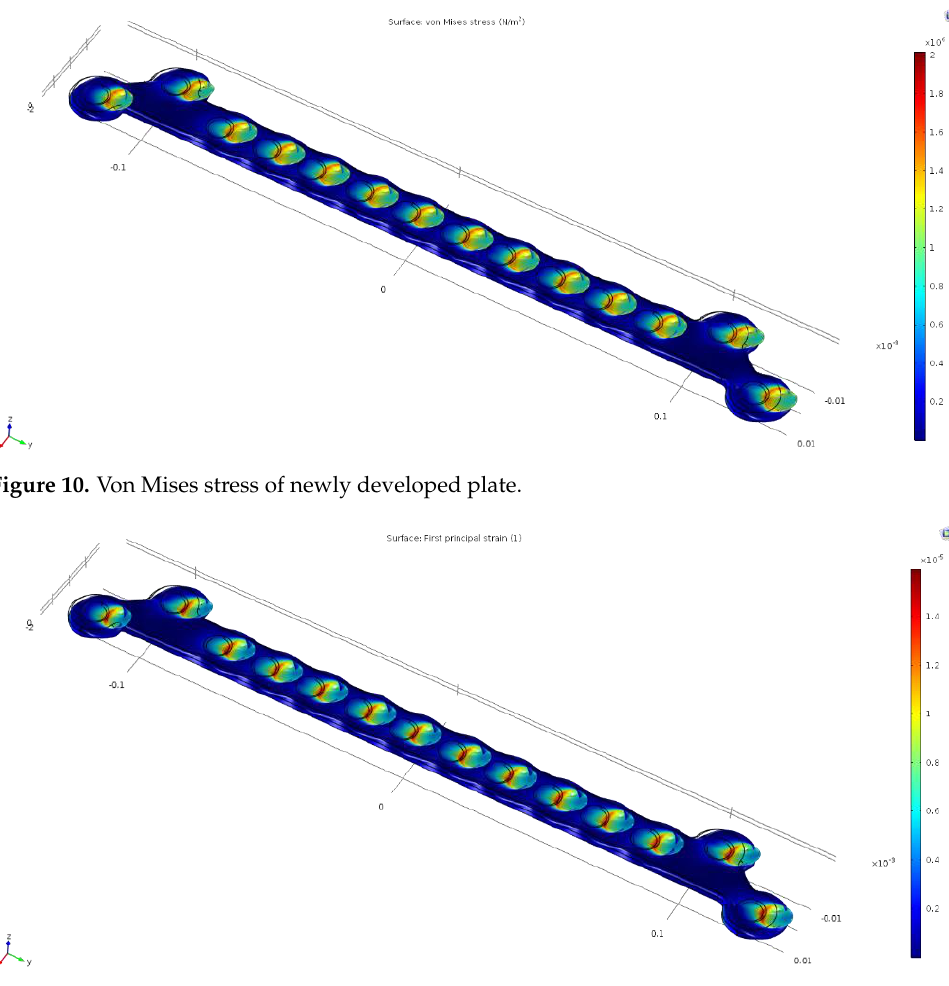
Figure 11. First principal strain of newly developed plate.